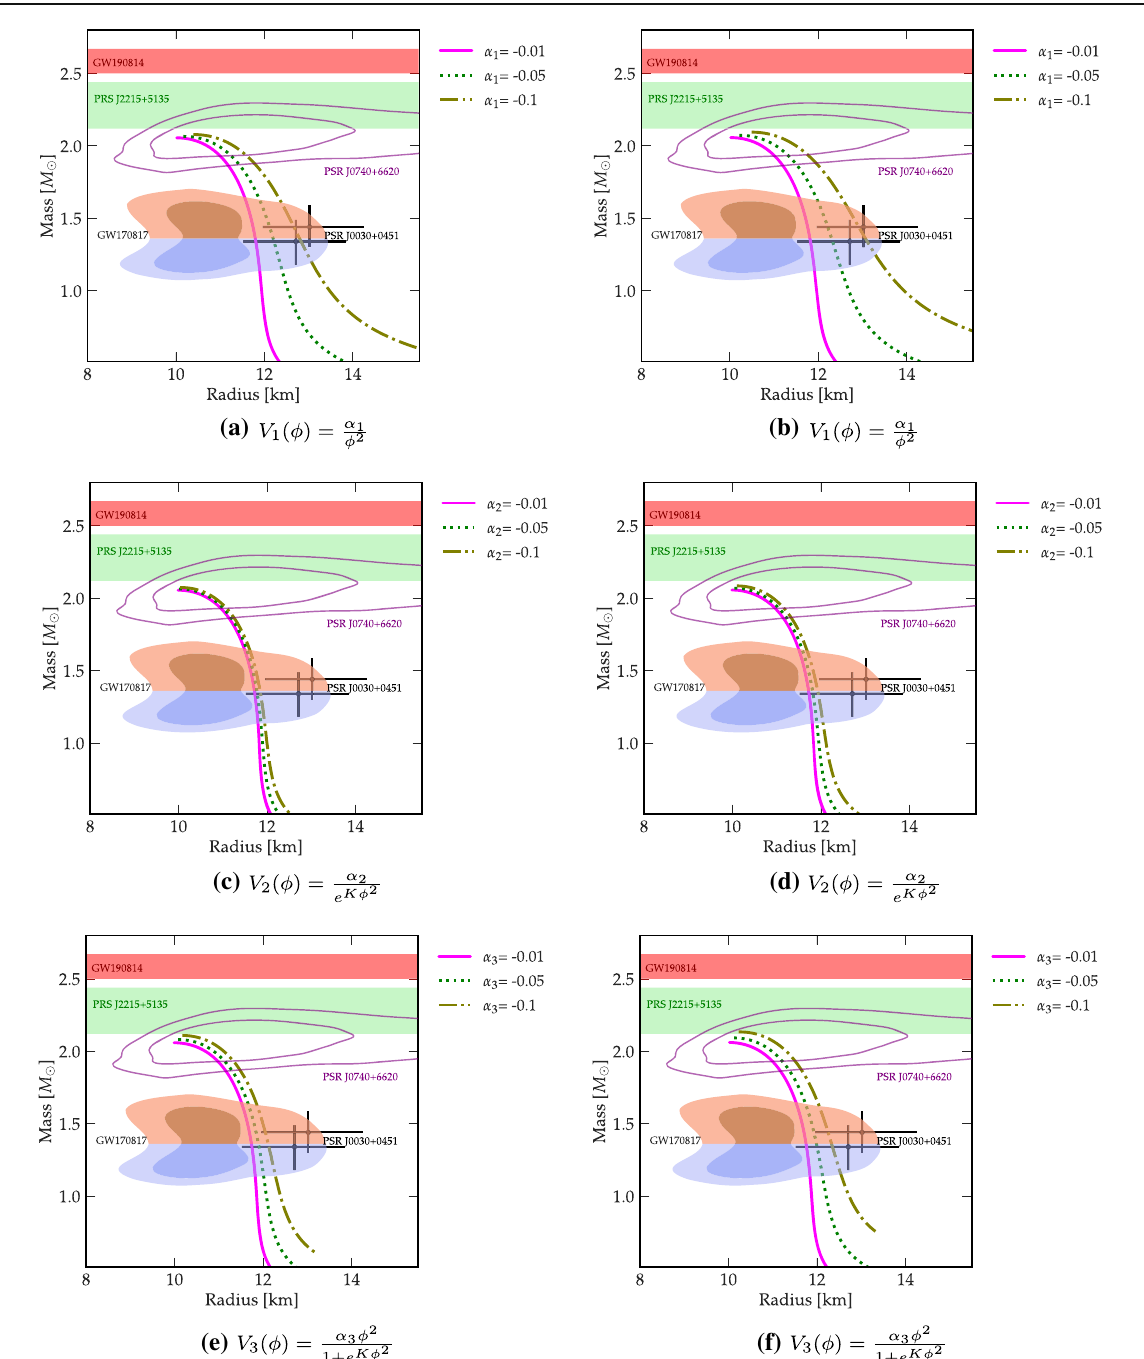
Fig. 2 The mass–radius relation of neutron stars in mimetic gravity for SLy4 EoS. φ( 0 ) = 1: left panels and φ( 0 ) = 0 . 8: right panels and K = 0 .